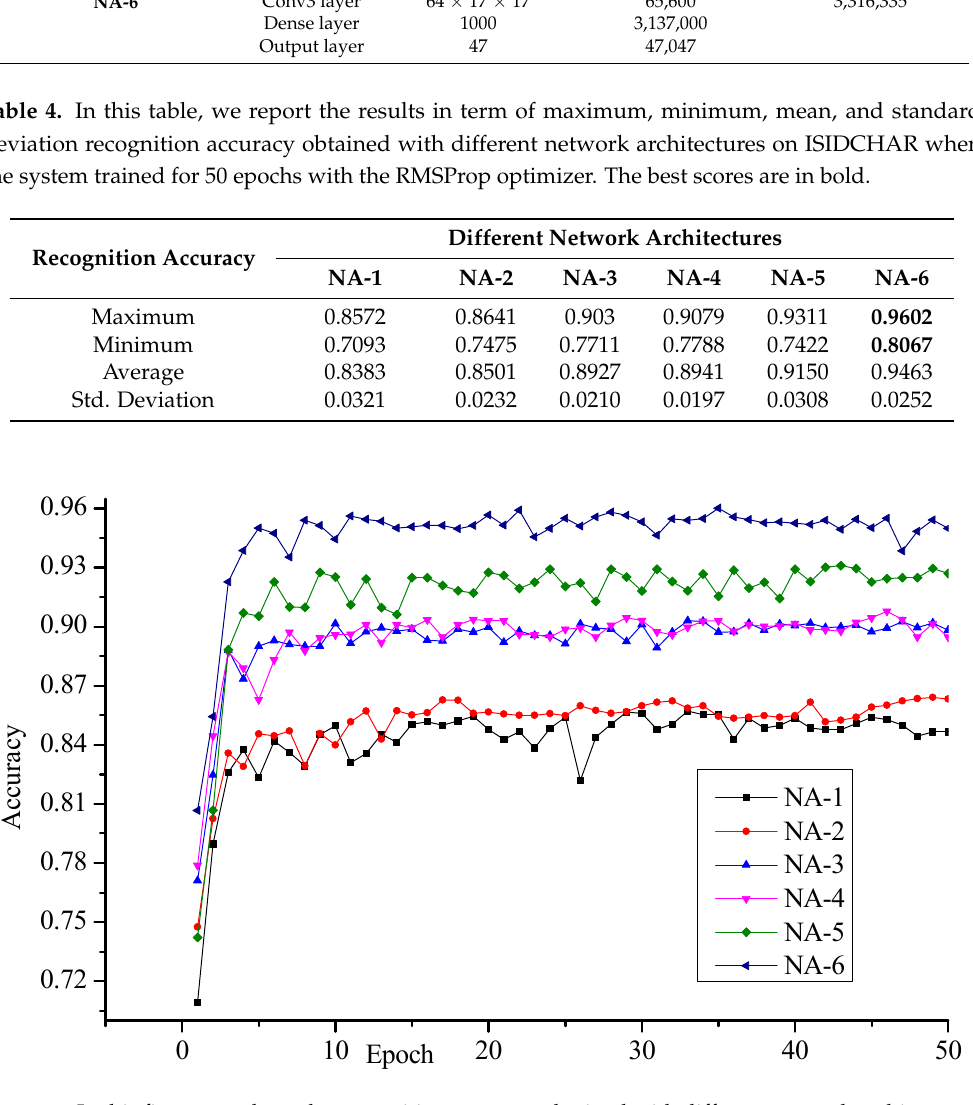
Figure 4. In this figure, we draw the recognition accuracy obtained with different network architectures on the ISIDCHAR database at each epoch. The RMSProp optimizer was used.